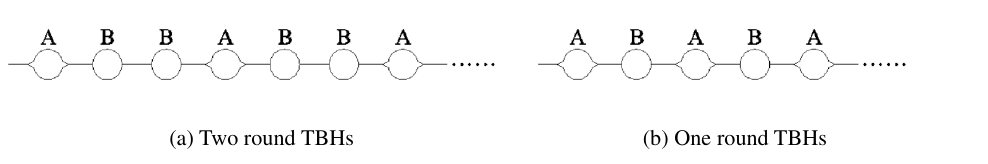
Figure 13. TSC fracture blasting circuit for PBH